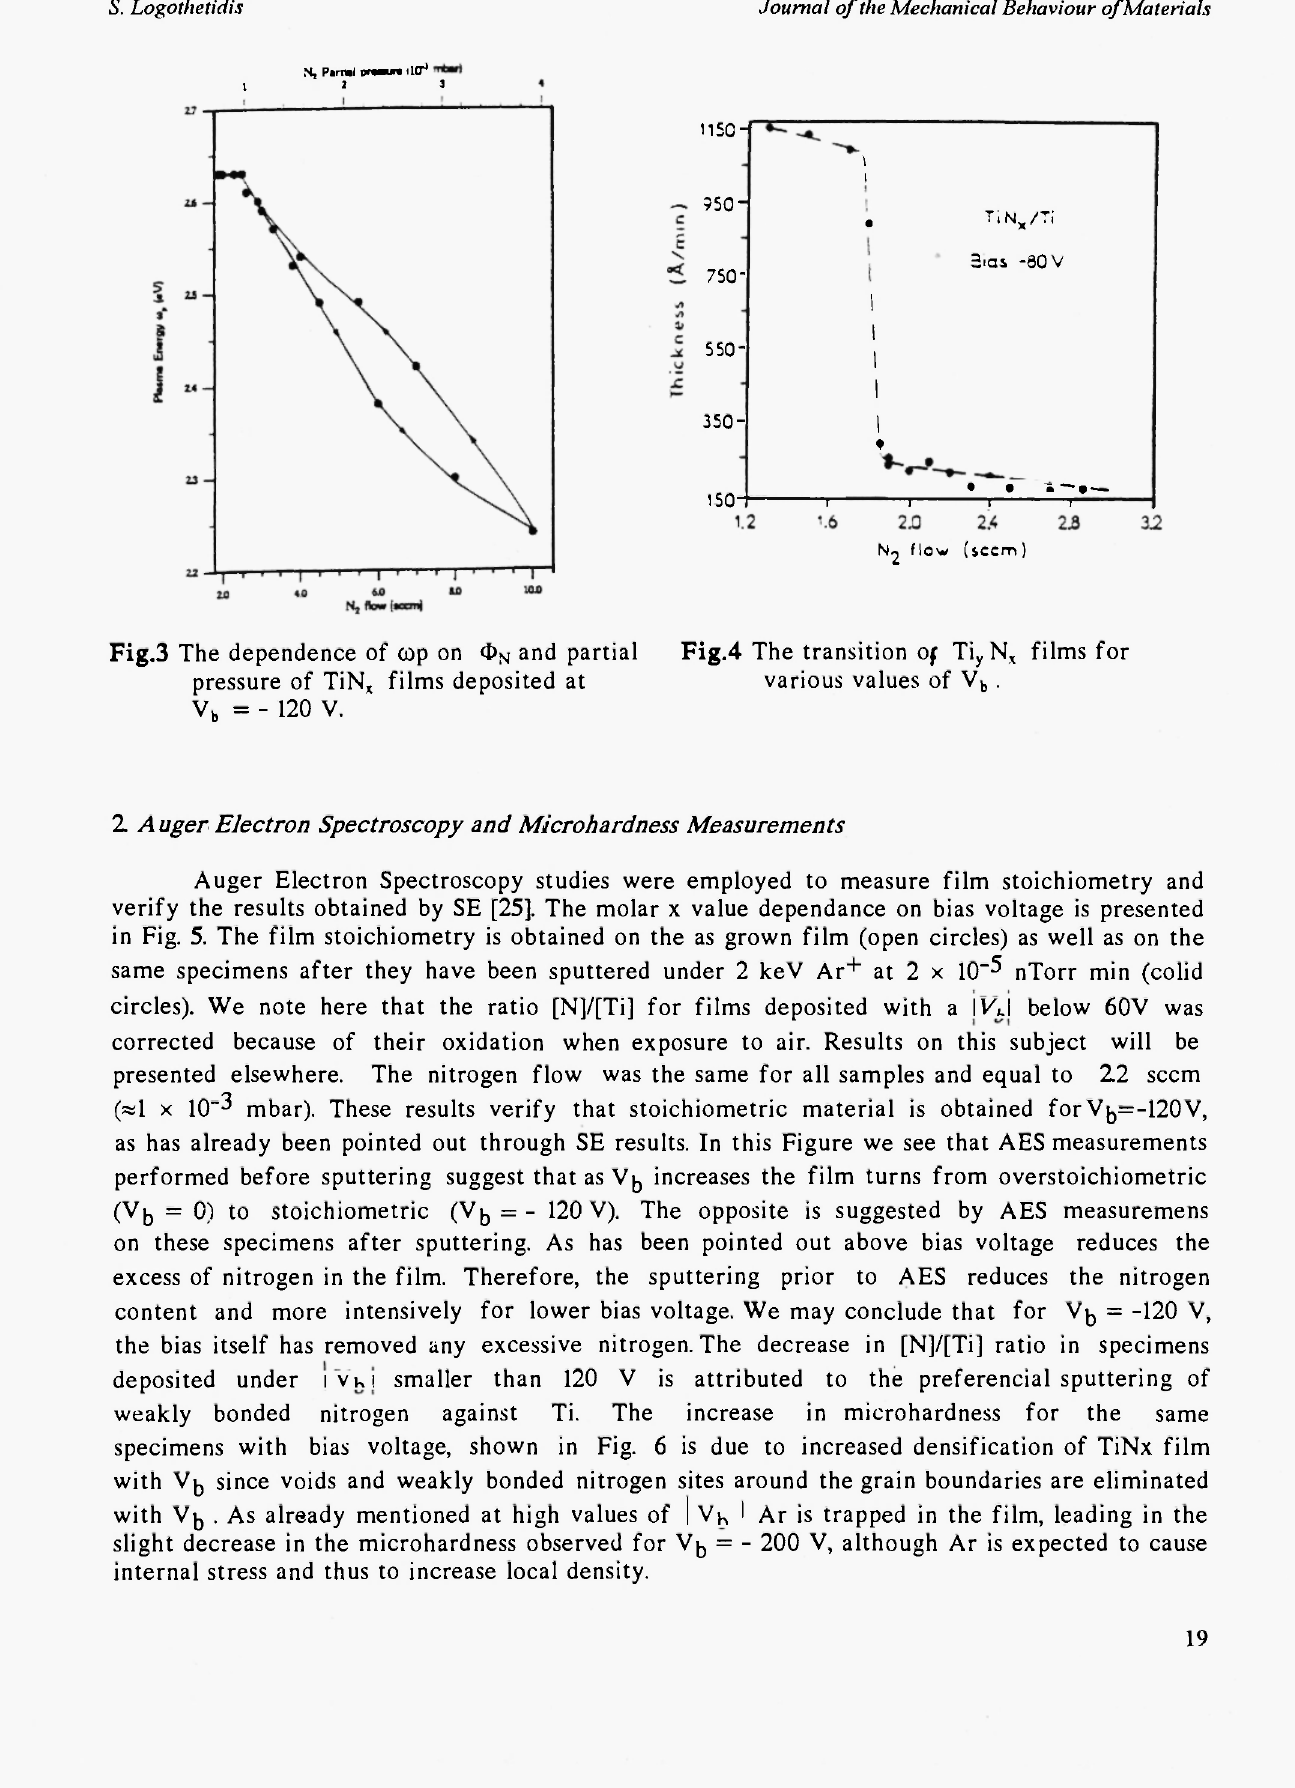
Fig.4 The transition of Ti y N x films for various values of V b